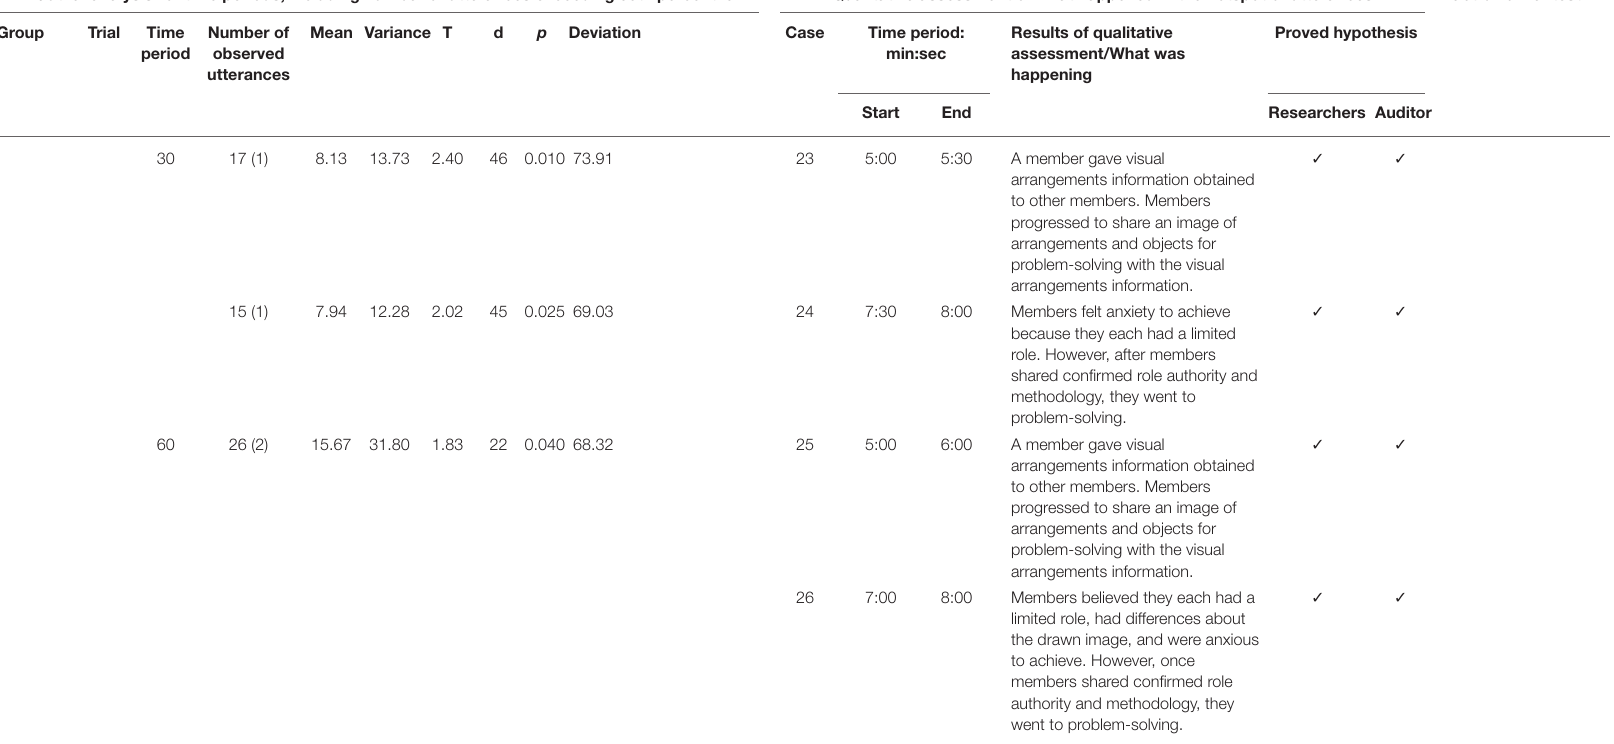
* Smirnov-Grubbs test (One-side